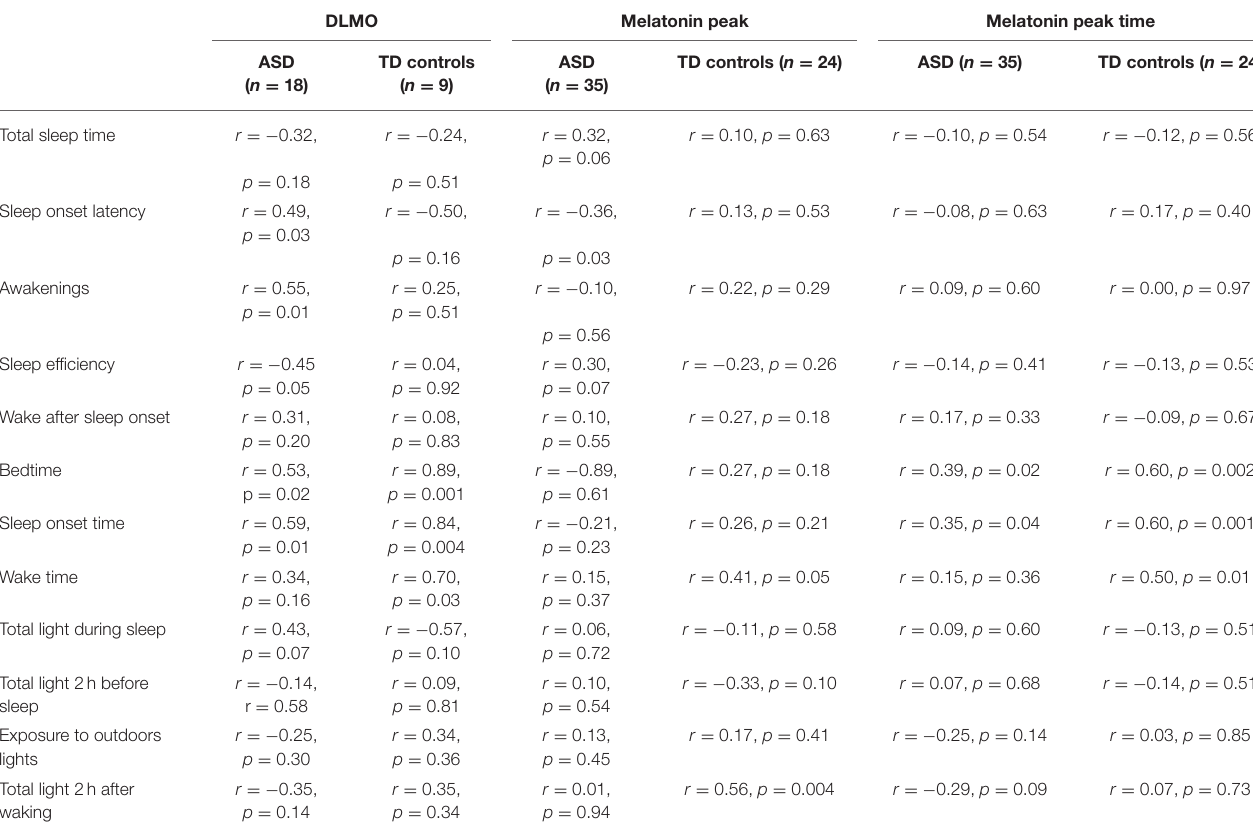
TABLE 4 | Correlations among DLMO, melatonin peak, melatonin peak time, and sleep parameters. DLMO Melatonin peak Melatonin peak